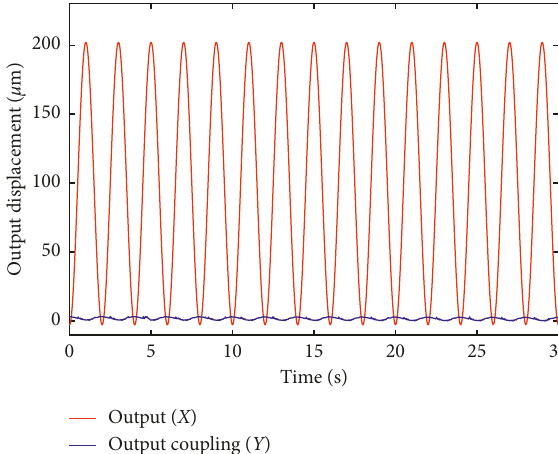
Figure 19: Coupling error of the translational part.